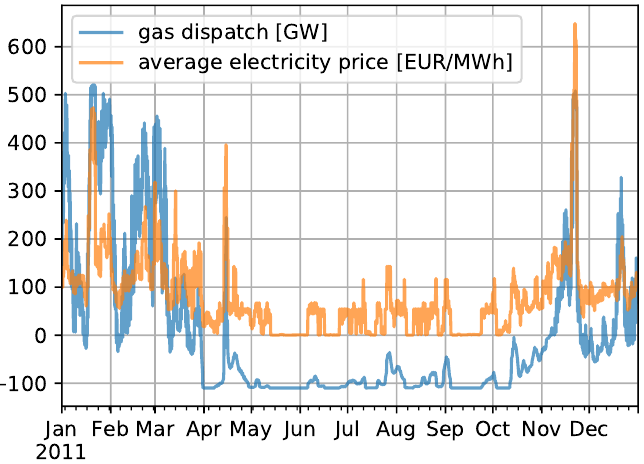
Figure 11. Zero CO 2 scenario: Methane dispatch (positive when synthetic methane is consumed, negative when produced by methanation) versus average electricity